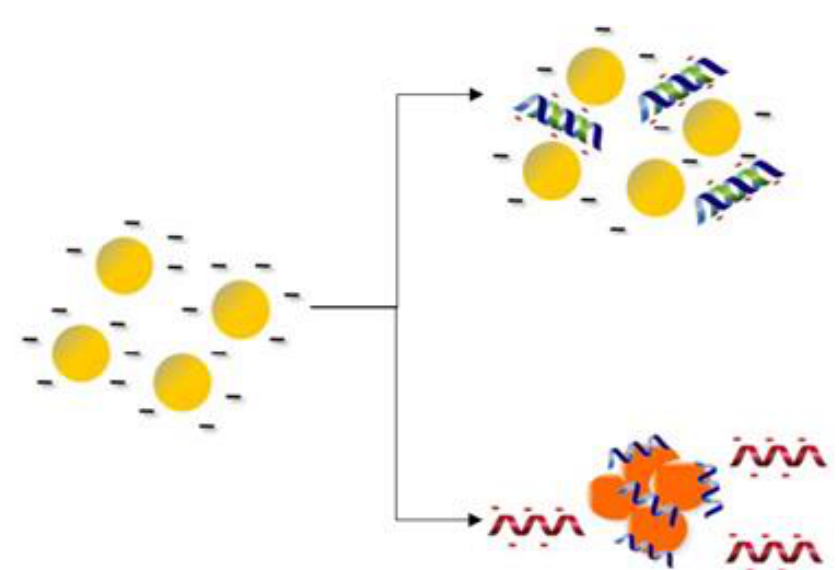
Figure 6. The schematic diagram shows a colorimetric detection that involves the color change of AgNPs. In the presence of target DNA, the AgNPs solution remains yellow (non-aggregated), and in the absence of target DNA, the solution changes to red. Reproduced from Teengam et al. [99]. The fabrication of the paper-based colorimetric DNA biosensor was assembled using the principles of origami, which consisted of two layers. A wax printing technique was used to create PADs, and the Whatman Grade 1 filter paper was used to print the wax design. The top layer consists of four colorimetric detection zones and four control zones.